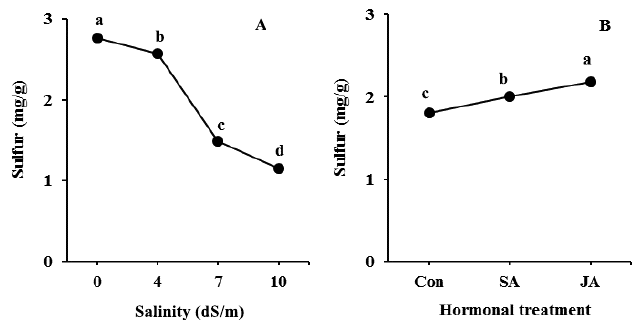
Fig. 2: Changes in sulfur content of soybean leaves under different salinity (A) and hormonal (B) treatments Different letters indicate significant difference at p ≤